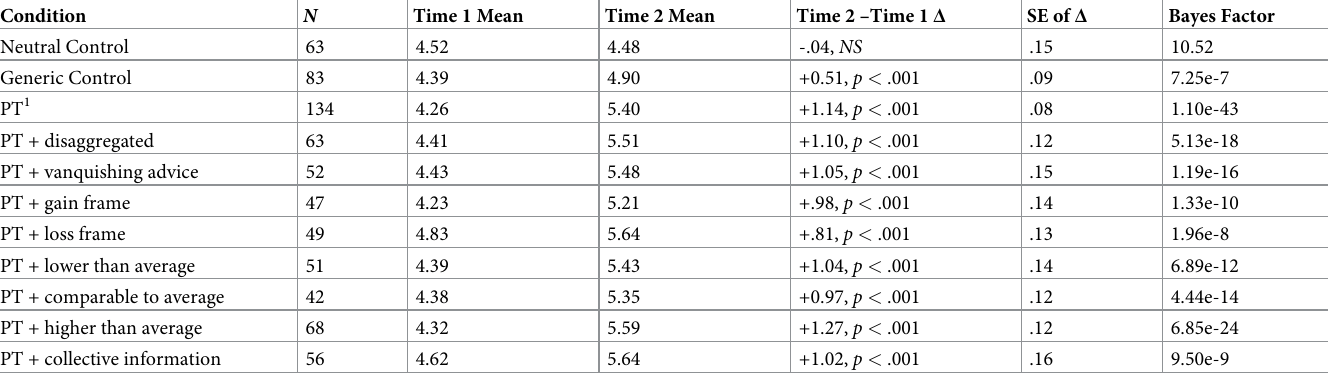
Table 2. Knowledge of standby power per